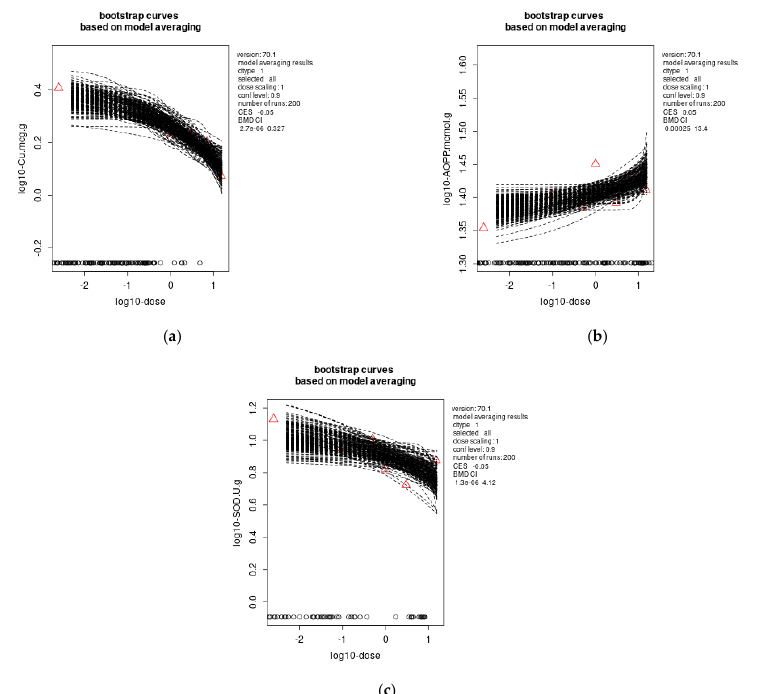
Figure 2. Benchmark dose modeling of liver Cu ( a ) and AOPP ( b ) levels, and kidneys’ SOD ( c ) activity as a response to the external Pb dose (mg/kg b.w./day), using a model averaging method with 200 iterations, PROASTweb70.1 software (https://proastweb.rivm.nl/). The red triangles represent the medians.